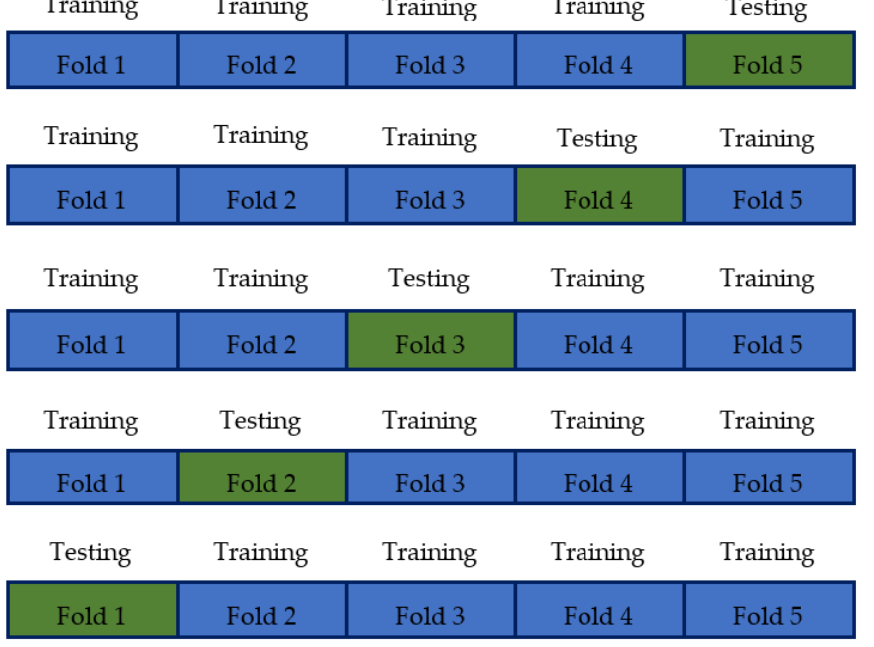
Figure 5. Schematic demonstration of a 5-fold leave-one-out cross-validation process.